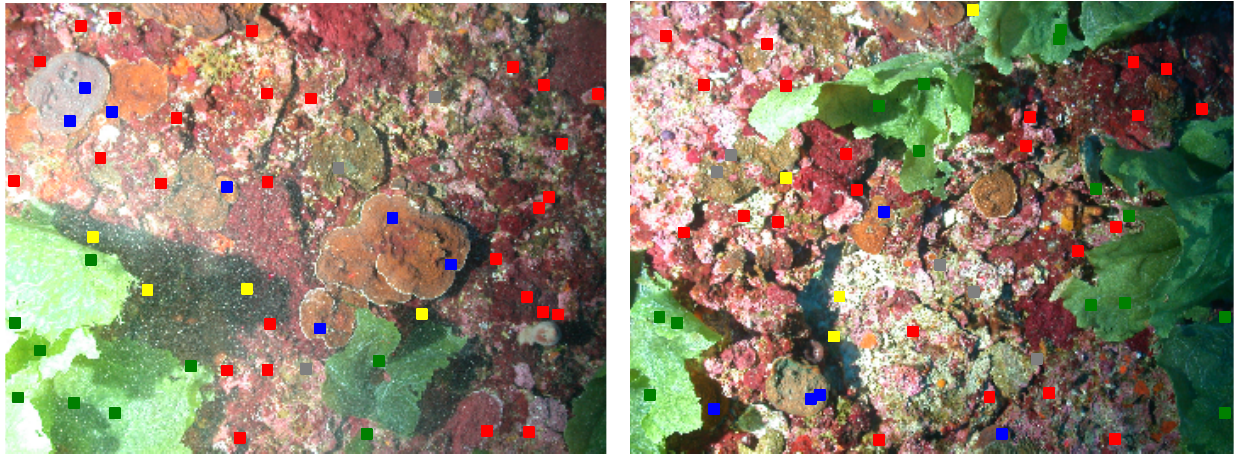
Figure 1. Point-supervision : there are only 50 points pixel labels in each image, blue color represents coral, green color represents green algae, red color represents red algae, gray color represents rock and yellow color represents other